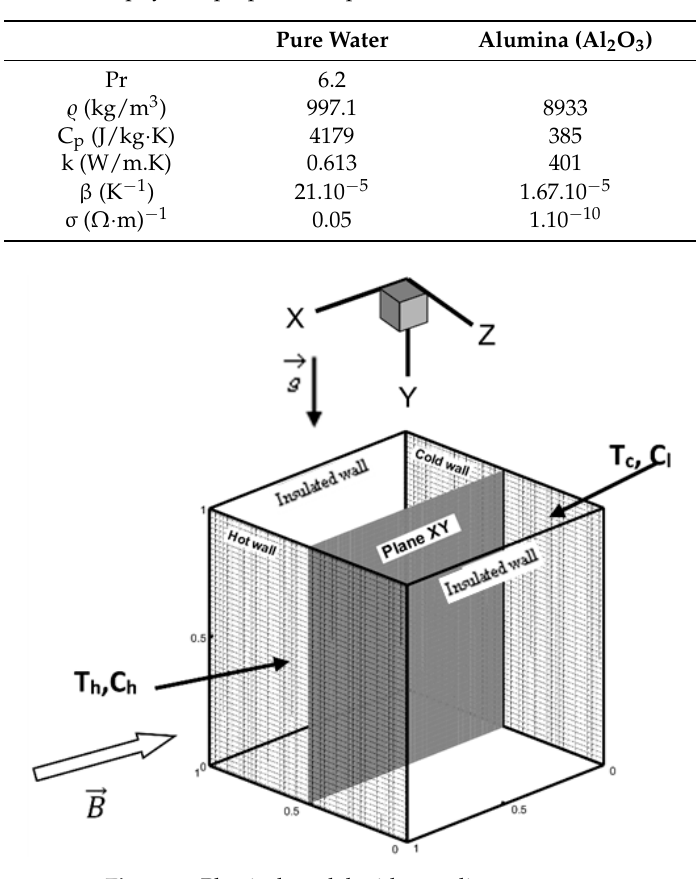
Figure 1. Physical model with coordinate system.